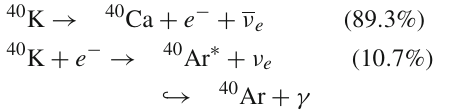
ing Cherenkov light can be recorded by two OMs almost simultaneously. Such coincidences are used to derive the rel- ative photon detection efficiencies [15] and for time calibra- tion between OMs in the